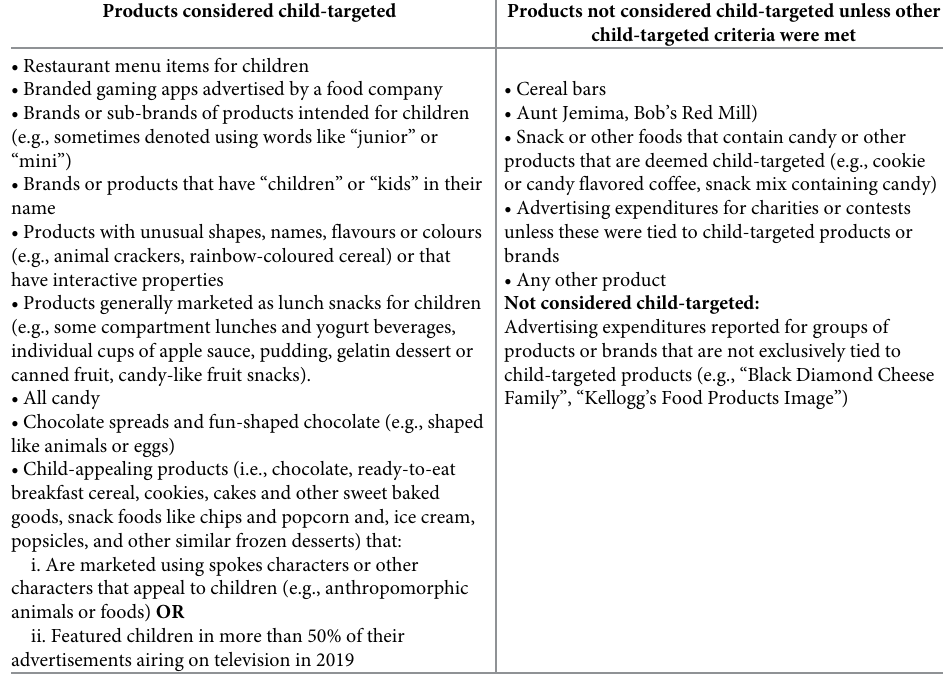
Table 1. Criteria for identifying “child-targeted” products. Products considered